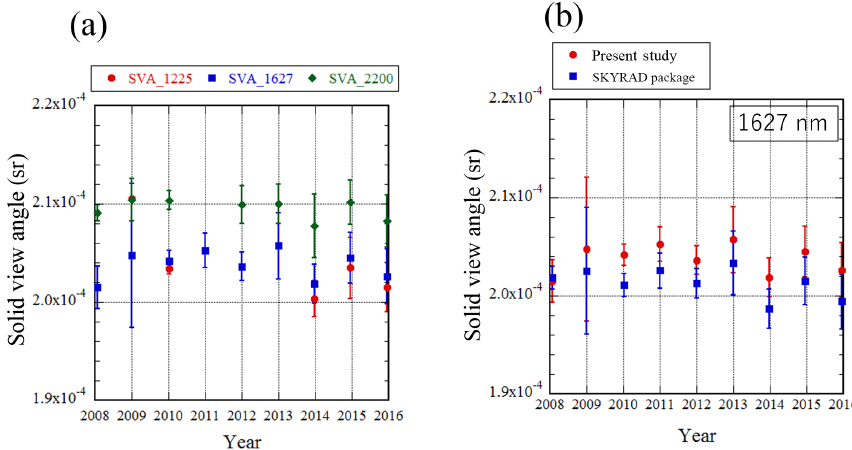
Figure 6. Same as Fig. 5 but for the shortwave-infrared region (InGaAs photodiode). The wavelength in (b) is